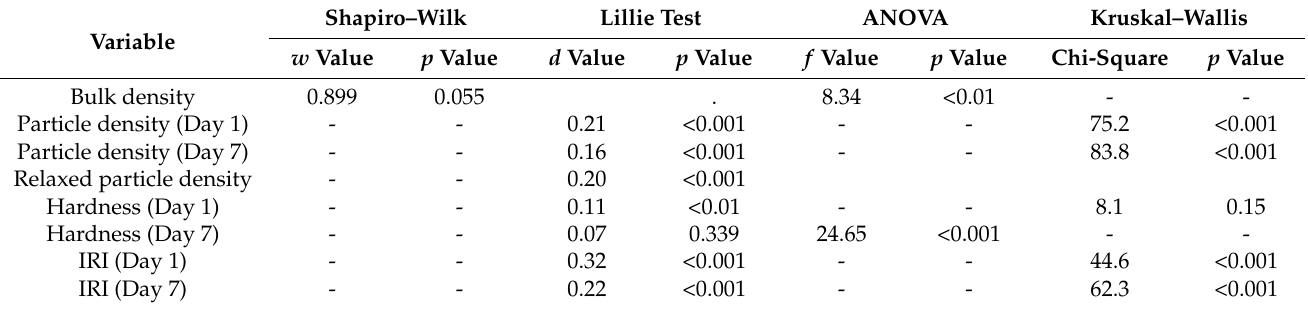
Table 4. Normality tests and analysis of variance of physical and mechanical properties of pellets made with Agave durangensis fibers and Pinus spp. sawdust mixtures.